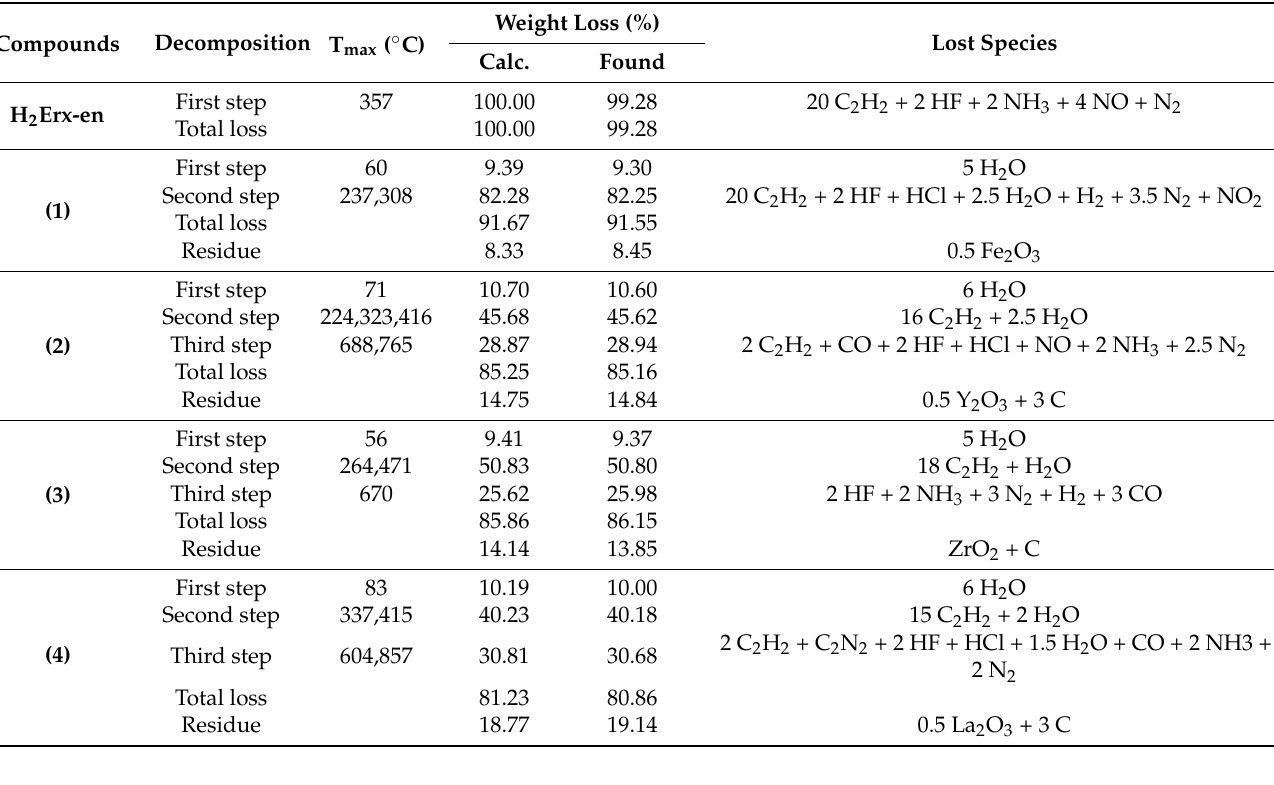
Table 5. The maximum temperature Tmax ( ◦ C) and weight loss values of the decomposition stages for H 2 Erx-en and its metal